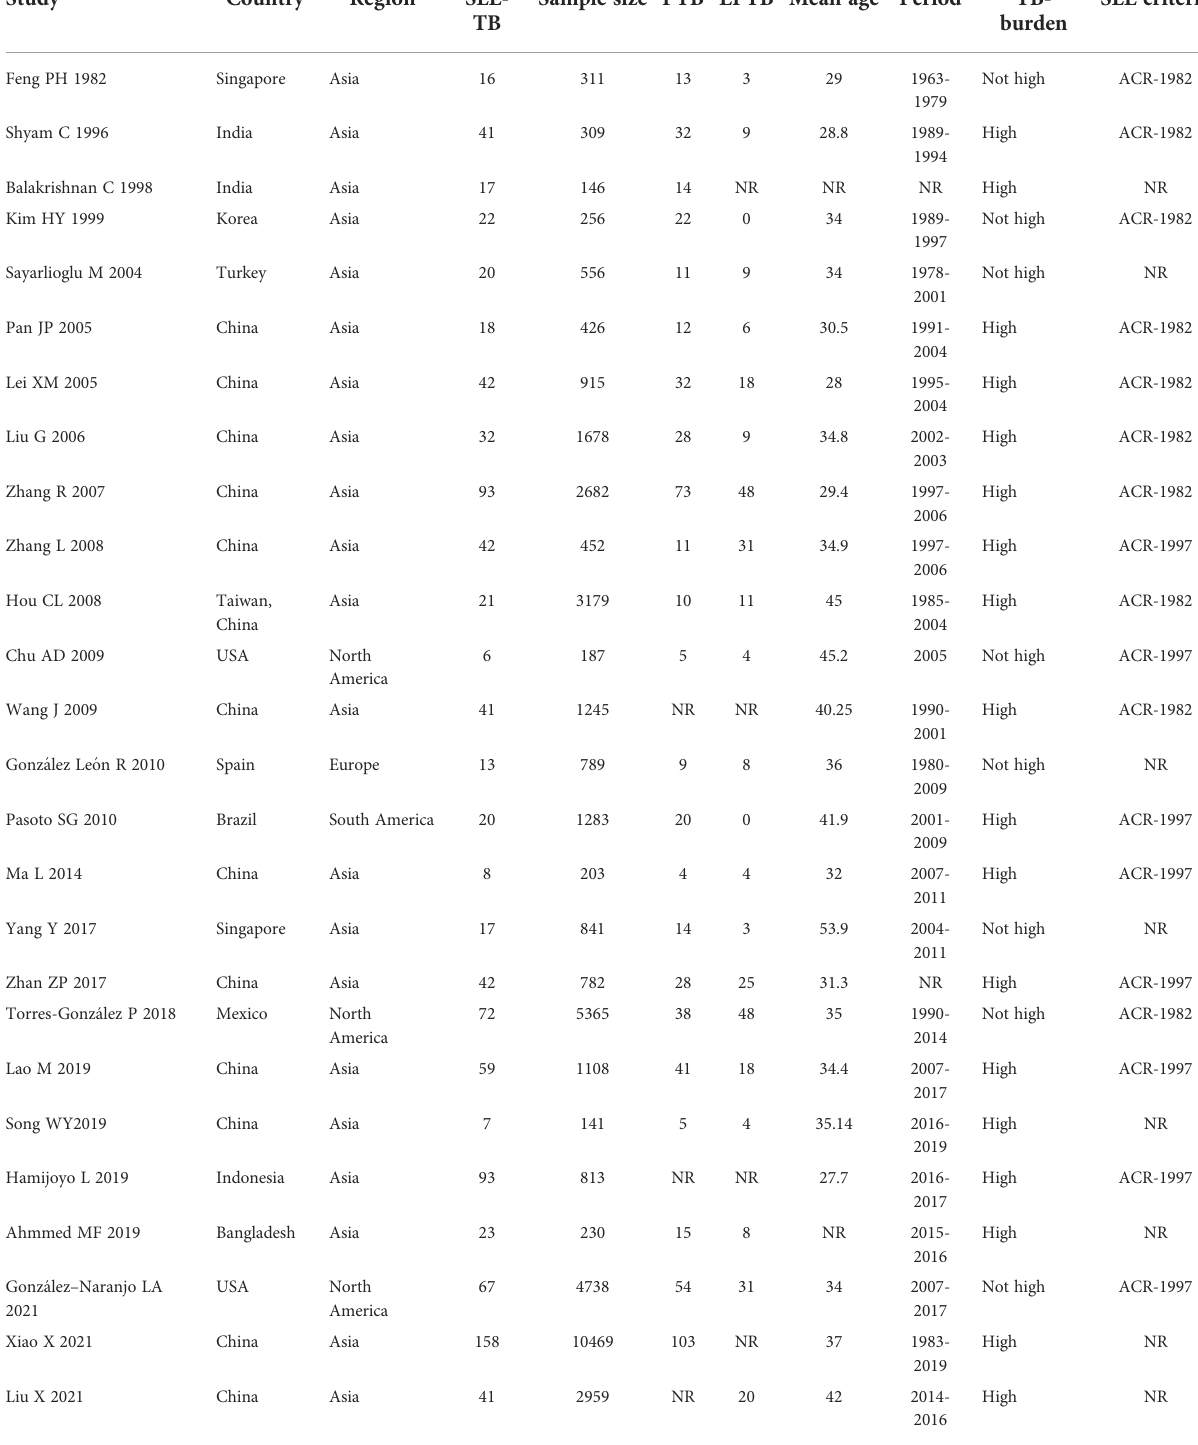
TABLE 2 Summary of the studies that reported the TB prevalence among SLE patients.